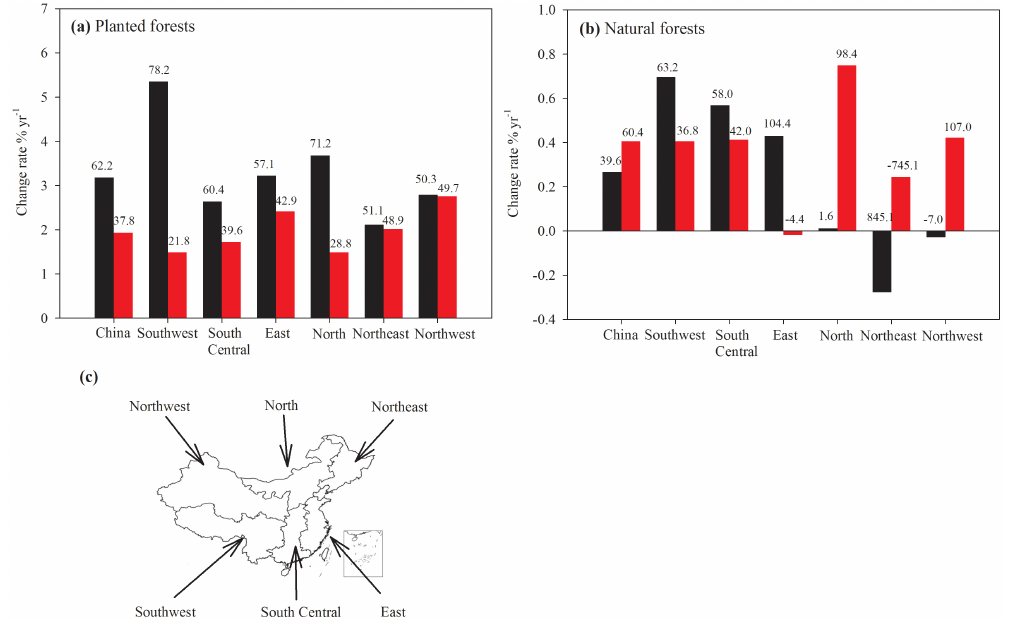
Figure 1. Rate of change and the relative contributions of forest area and biomass density to carbon sinks in planted (a) and natural (b) forests in six broad regions of China for the period 1977–2008. The division of these six broad regions is indicated in (c) . Bars and numbers above represent the rates of change and the relative contributions of forest area (in black) and carbon density (in red), respectively.